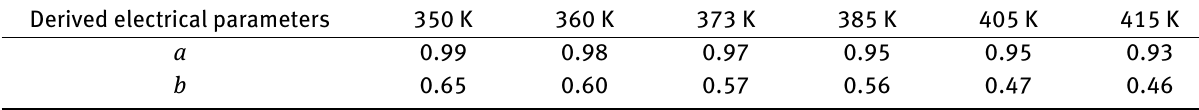
Table 3: Derived electrical parameters (shape parameters) from from electrical modulus spectra analysis. Derived electrical parameters